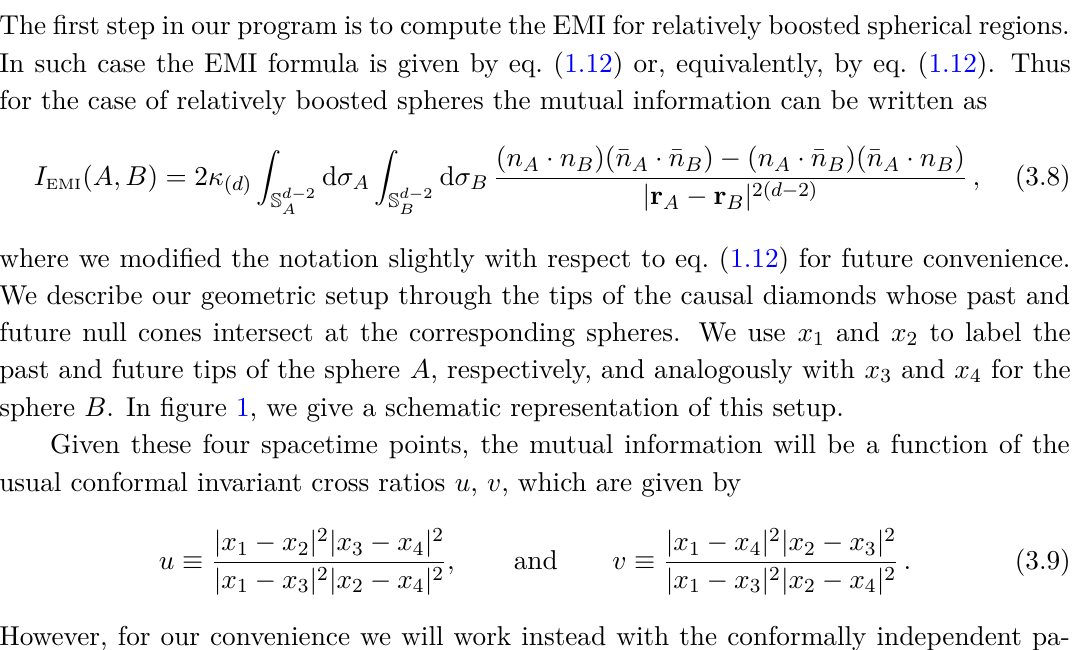
Figure 1 . Schematic representation of the geometric setup. We consider two boosted spheres S d − 2 S d − 2 , characterized by their causal tips x 1 , x 2 and x 3 , x 4 , respectively. The vector joining x 1 and B x 3 is denoted Ll and the ones connecting the diamond tips of each sphere by 2 R A n A and 2 R B n B ,